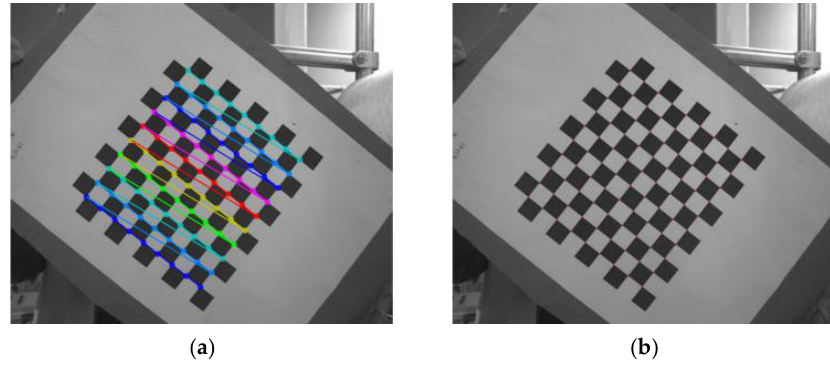
Figure 10. Camera calibration diagram. ( a ) Calibration object; ( b ) Reproject.